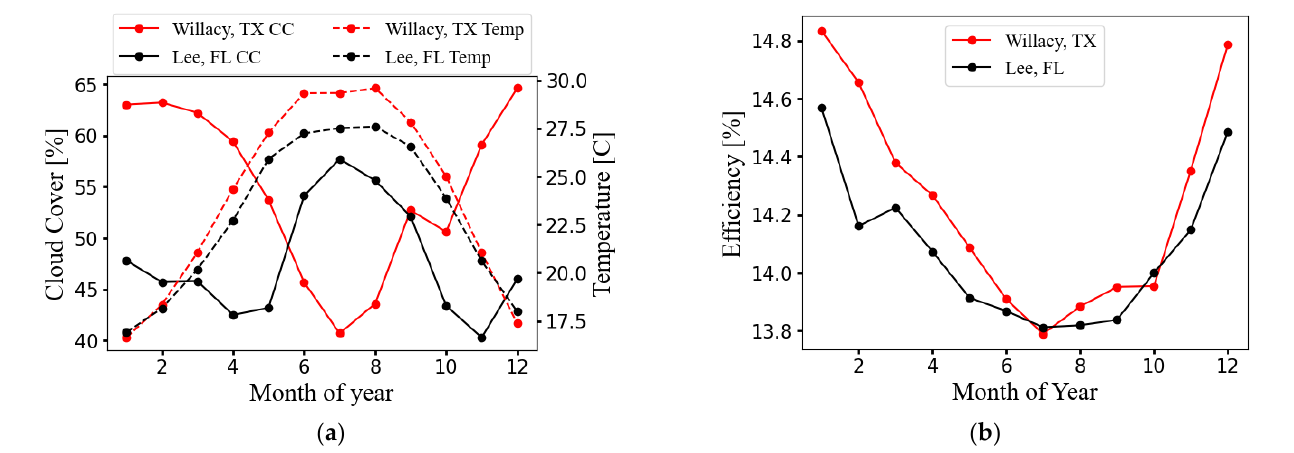
Figure 10. ( a ) Comparison of seasonal cloud cover and ambient temperatures for case 3 indicated in Figure 5. ( b ) The temperature dependent efficiency of PV panels for case 3 locations.